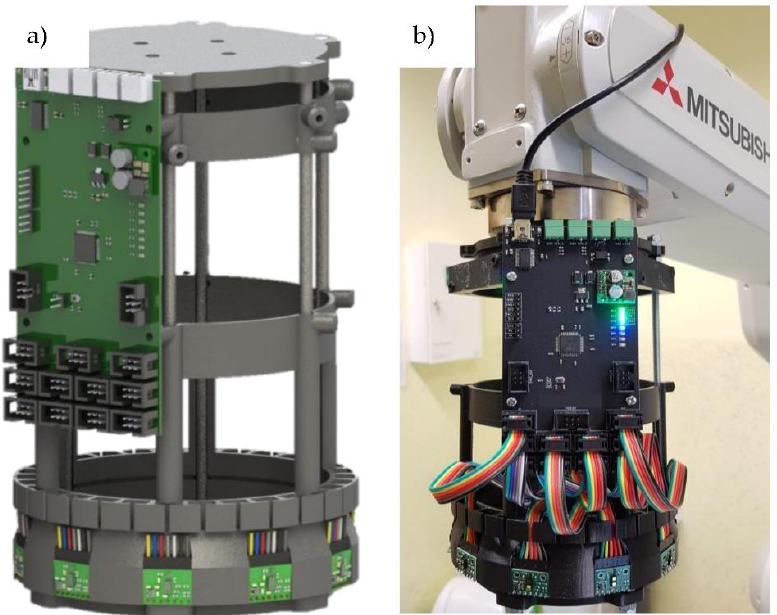
Figure 5. The head designed to detect obstacles: ( a ) CAD project; ( b ) head attached to the wrist of the robot.